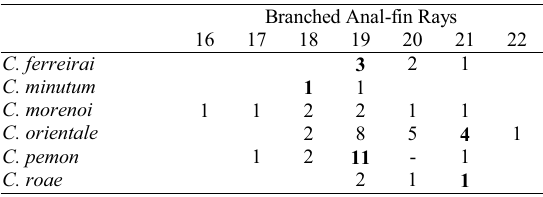
Table 3 . Number of specimens of the species of Cetopsidium with cited number of branched anal-fin rays. Bold indicates value for holotype when examined.